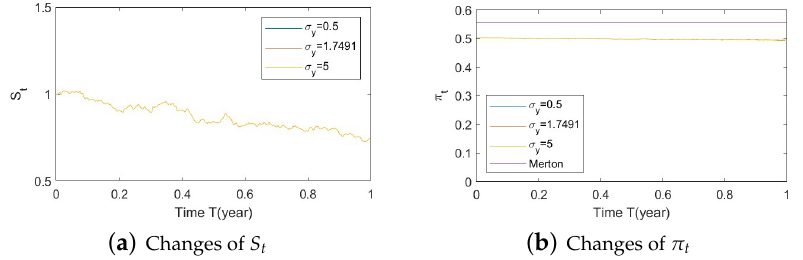
Figure A33. Illustrate the impact on ( a ) stock prices and ( b ) optimal stock allocations when varying σ y ( e . g ., σ y = 0.5,1.7491,5 )